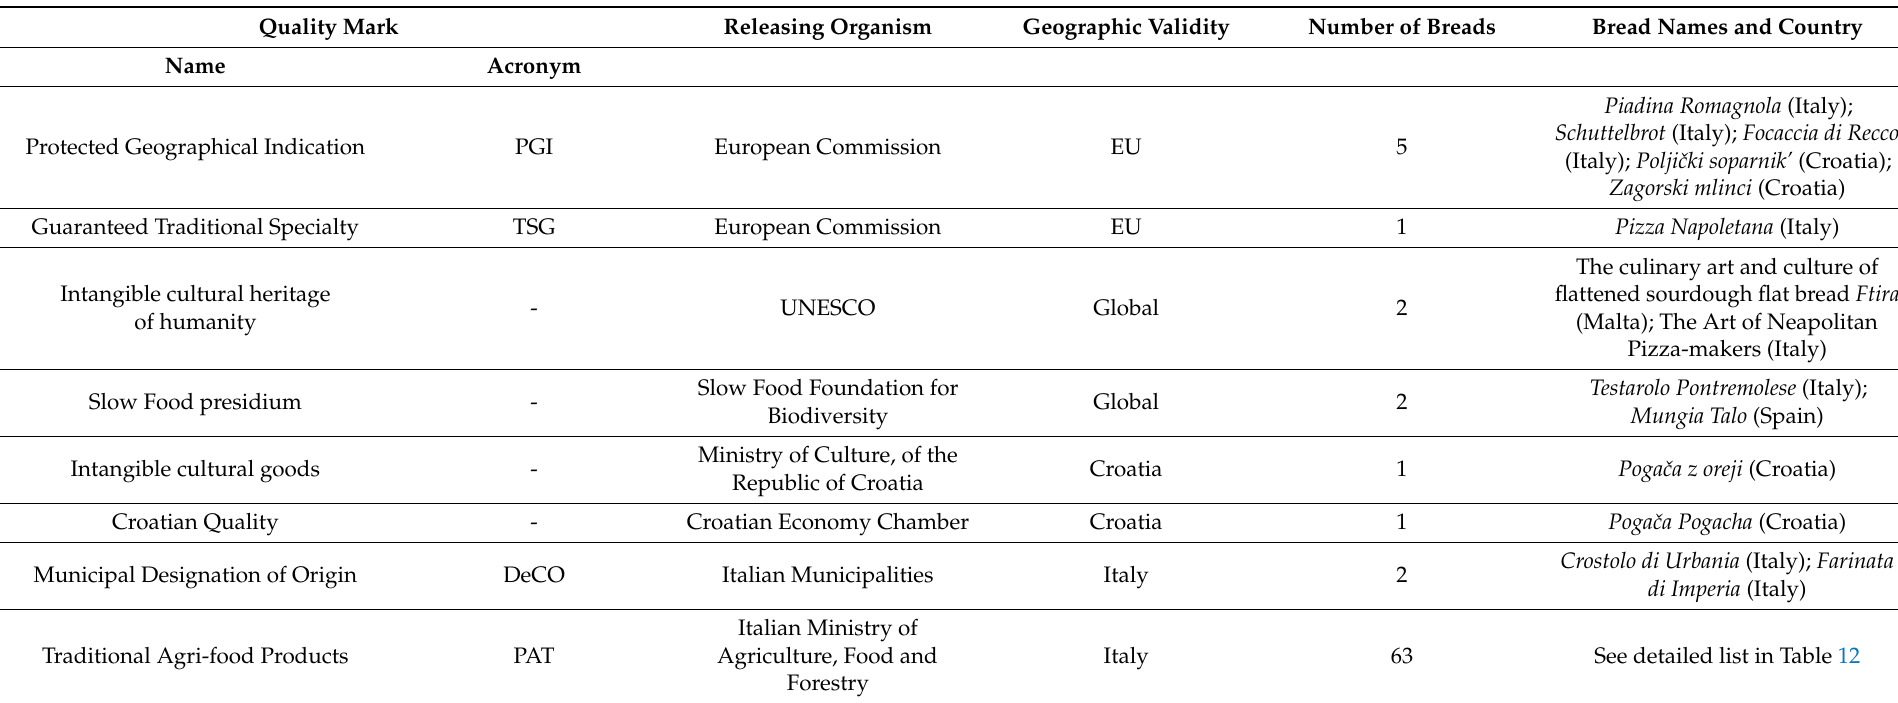
Table 11. Flat breads awarded by quality marks. PGI = Protected Geographical Indication; TSG = Traditional Specialty Guaranteed; PAT = Prodotti agroalimentari